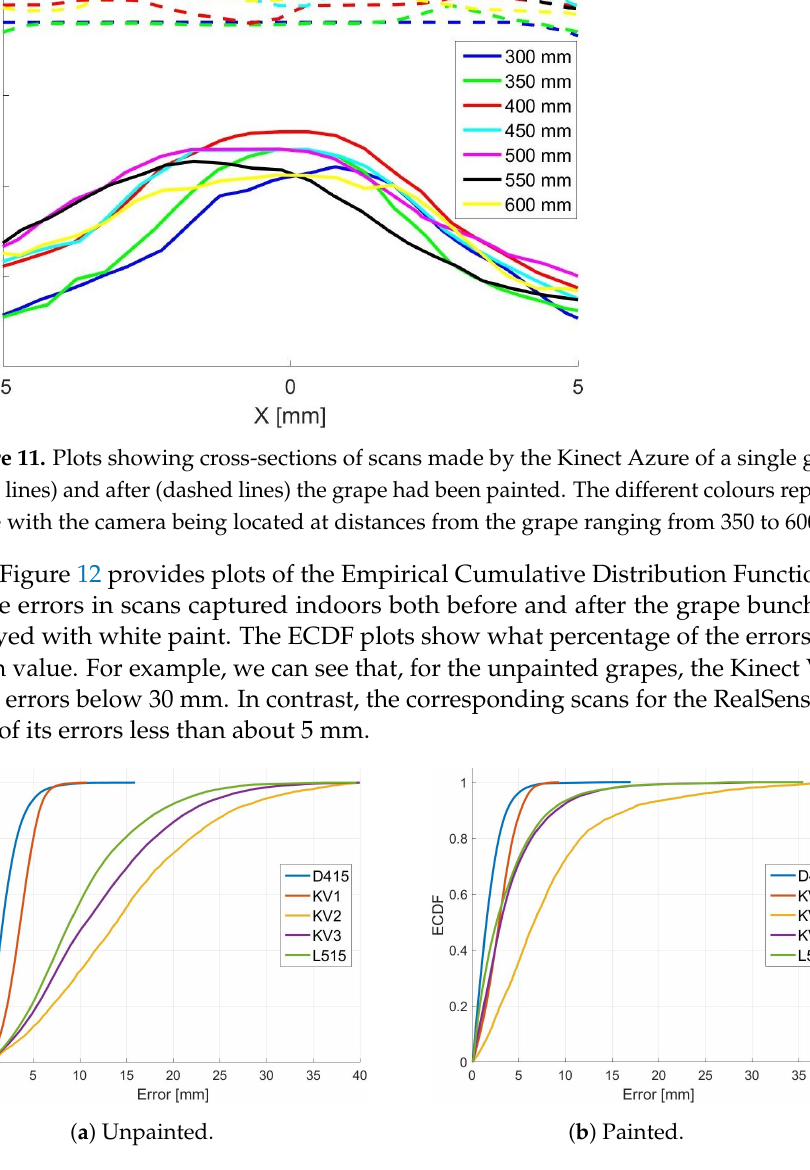
Figure 12. Plots ( a , b ) respectively show the ECDF error measurements for the grape bunch scans made indoors before and after the grapes had been sprayed with paint. The cameras were positioned 600 mm from the